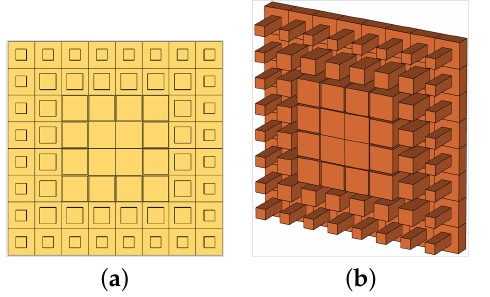
Figure 4. Pictorial views of the proposed prototype. ( a ) Top view. ( b ) Perspective view.